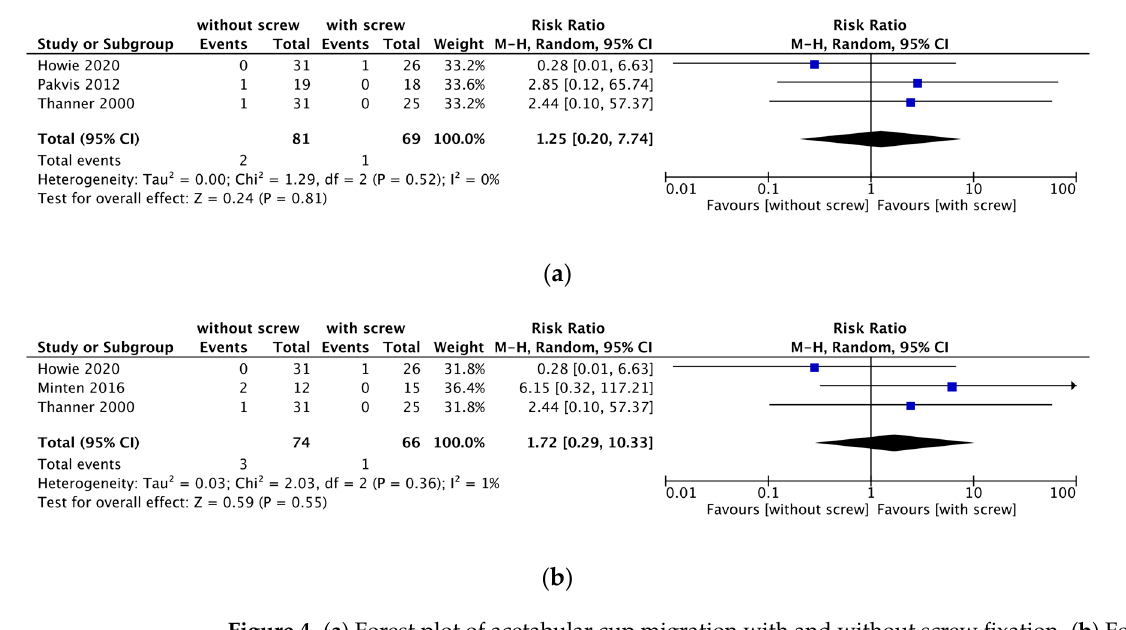
Figure 4. ( a ) Forest plot of acetabular cup migration with and without screw fixation. ( b ) Forest plot for sensitivity analysis for the cup migration [10–13].